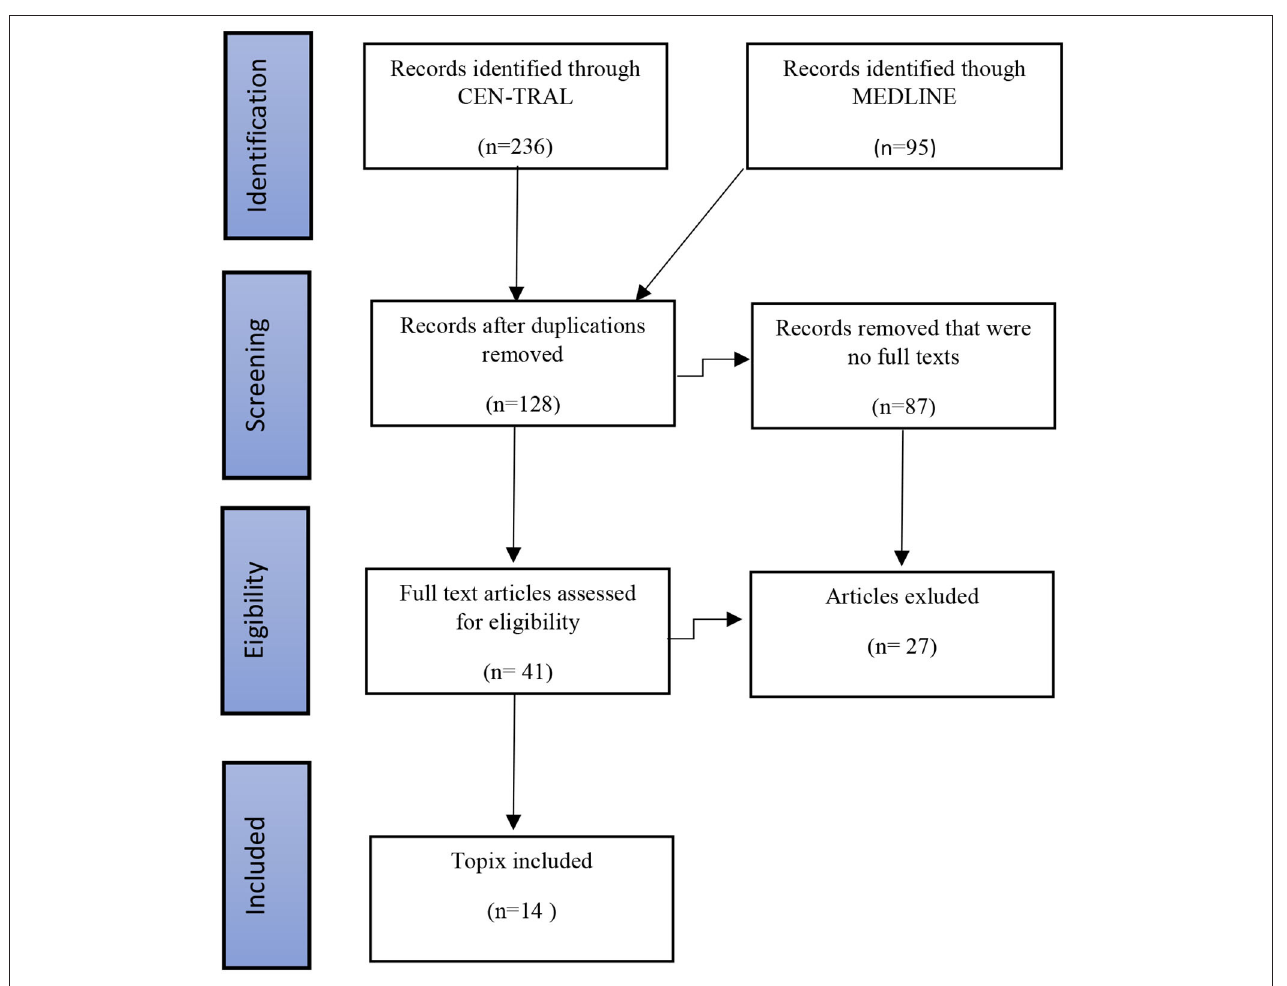
FIGURE 1 | Procedures followed for the identification of eligible studies examining SCC DBS for TRD using the PRISMA